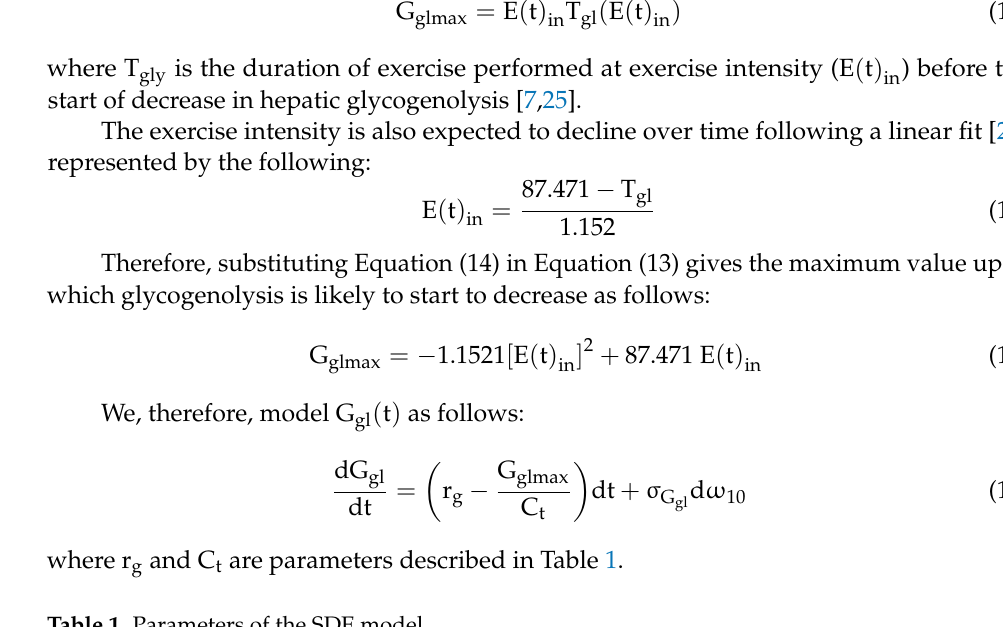
Table 1. Parameters of the SDE